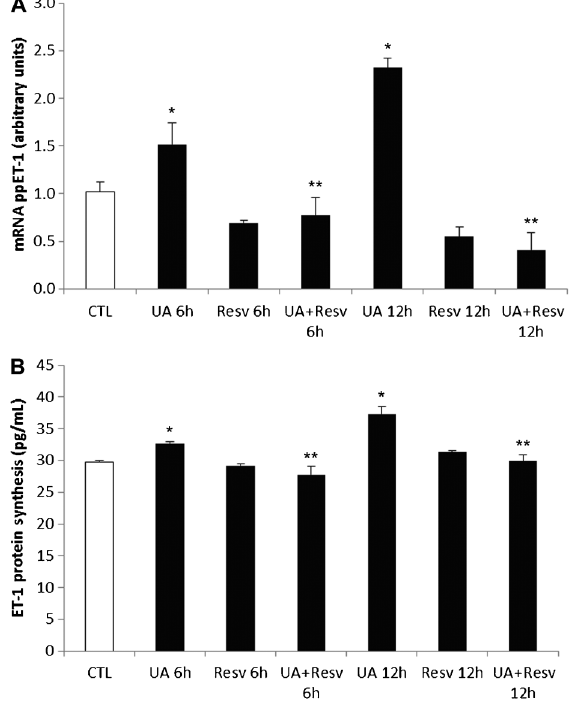
Figure 3. Effect of resveratrol (Resv) treatment (12.5 m M) on mRNA pre-pro endothelin-1 (ppET-1) expression ( A ) and ET-1 protein synthesis ( B ) in immortalized human mesangial cells (ihMCs) stimulated with uric acid (UA). Cells were seeded on plates and after 6 and 12 h were exposed to DMEM with 1% FBS containing 10 mg/dL UA and 12.5 m M Resv. Data are reported as means±SE. A , *P , 0.05 vs control (CTL); **P , 0.05 vs UA (Student t -test). B , *P , 0.05 vs CTL; **P , 0.001 vs UA (Student t